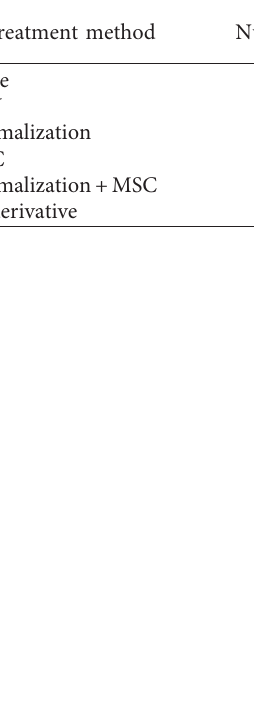
Figure 3: Regression coefficient diagram of the optimal crude protein